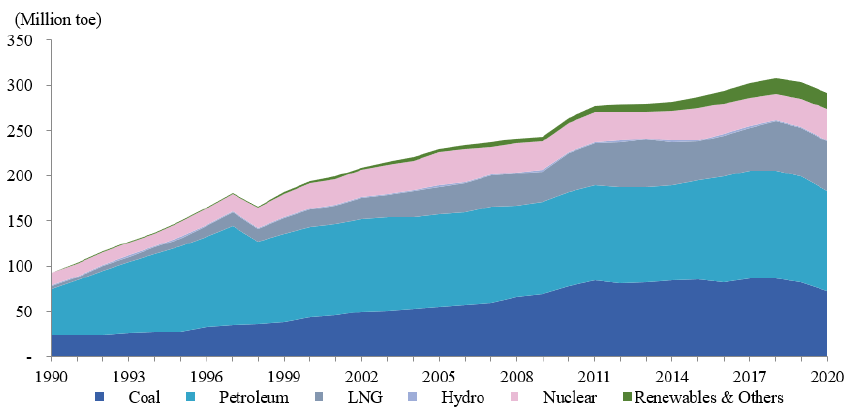
Figure 4. Primary sources of energy [45].